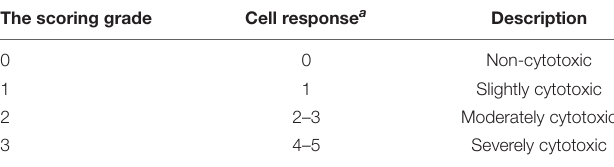
TABLE 4 | Cytotoxicity scoring